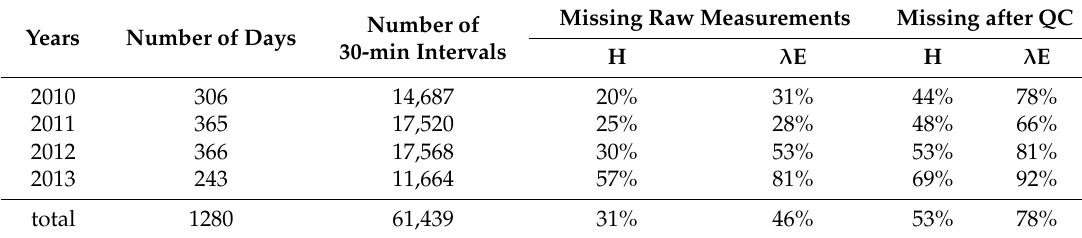
Table 1. Summary of the available flux data available before gap-filling, for the sensible (H) and latent ( λ E) heat fluxes. The number of 30-min intervals corresponds to the number of days of the experiment. The rates of missing data are given as percentages of the number of 30-min intervals for each year between March 2010 and August 2013. Missing raw measurements are due to experimental failures. Missing after quality control QC correspond to the sum of missing raw measurements and data eliminated by quality control (Section